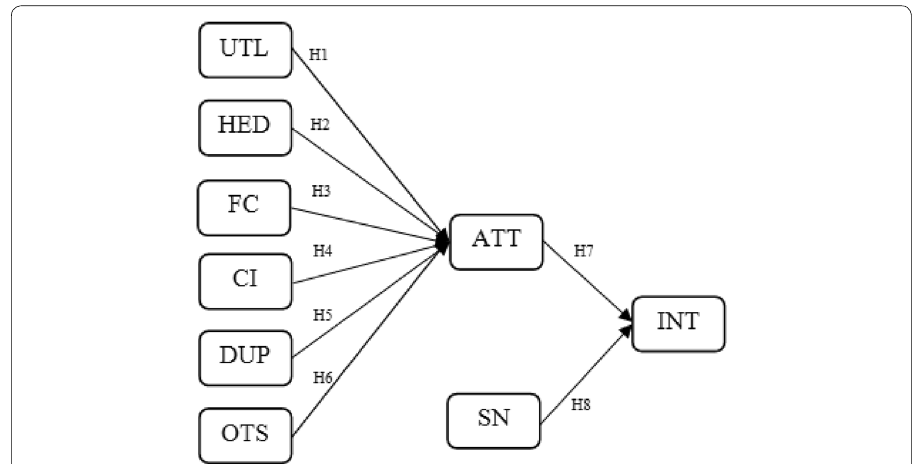
Fig. 2 The proposed research framework. UTL utilitarian motivations, HED hedonic motivations, FC fashion consciousness, CI consumer innovativeness, DUP desire for unique products, OTS online transaction self-effi- cacy, ATT attitude towards fashion/beauty SOS, SN subjective norm, INT intention to use fashion/beauty